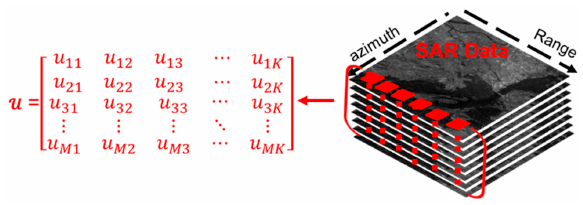
Figure 5. Range-Doppler Signal U in the range-elevation plane.